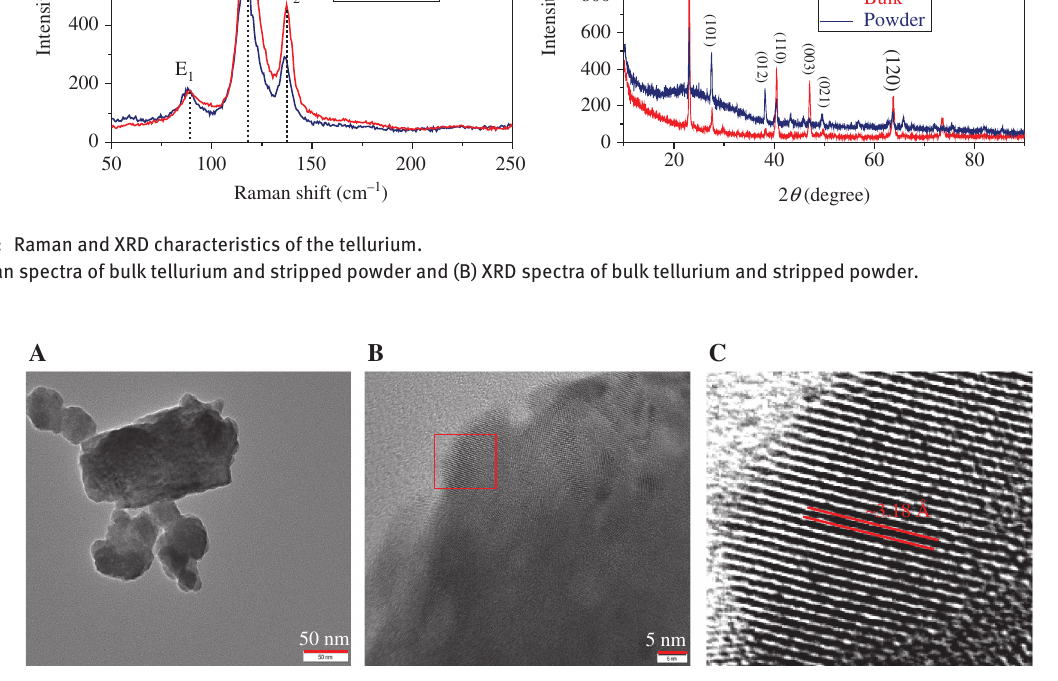
Figure 4: Structure characteristics recorded by the TEM. (A) TEM image and (B and C) HR-TEM images of tellurene